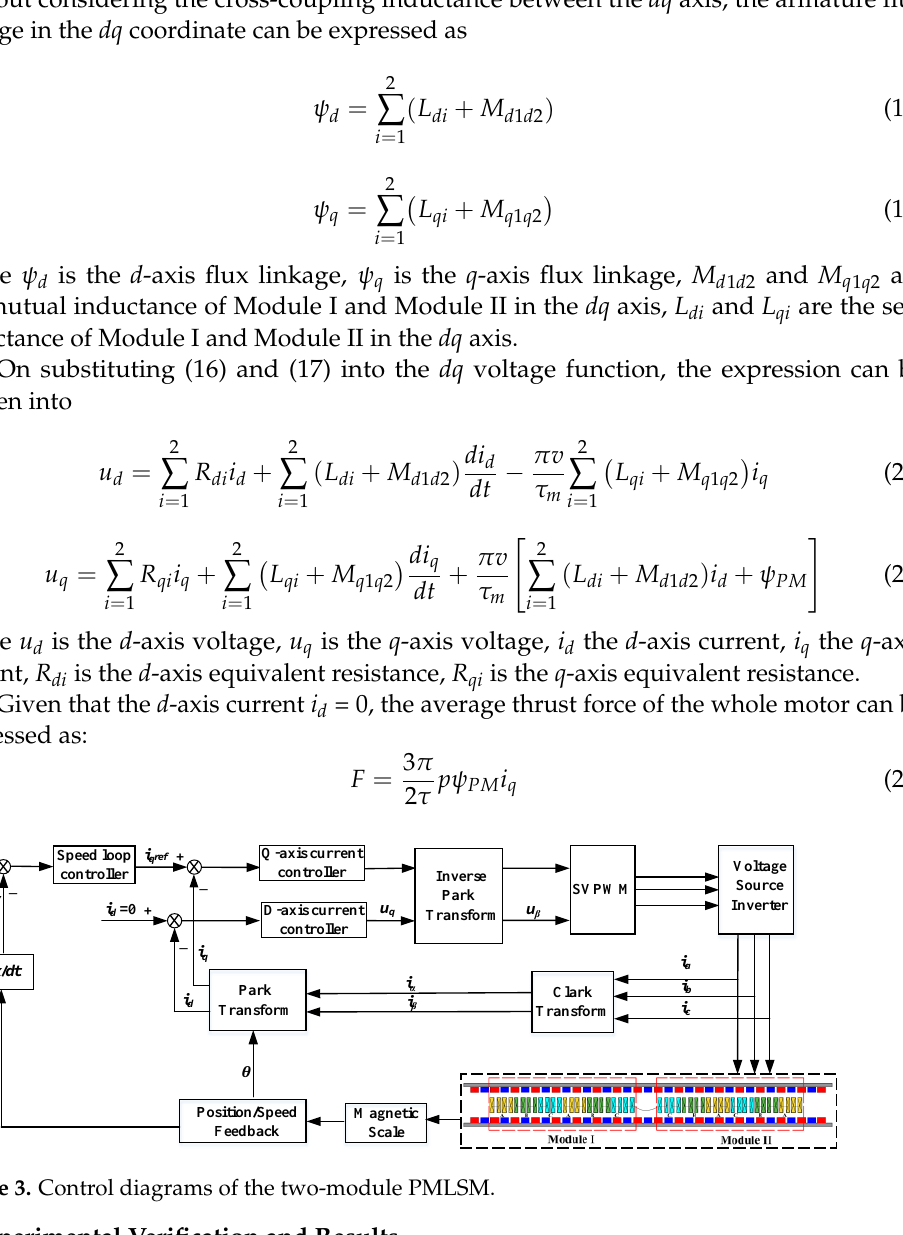
( b ) Figure 4. ( a ) Test platform of the two-module PMLSM . ( b ) Schematic diagram of the test platform. 5.2. FEM Results of the PM Flux Linkage and Inductance As seen, the above-derived mathematical models are nonlinear coupling equations. Some parameters of the analytical model are determined by FEM for the air-core linear motor to obtain accurate and fast results [27]. Hence, to obtain accurate computational